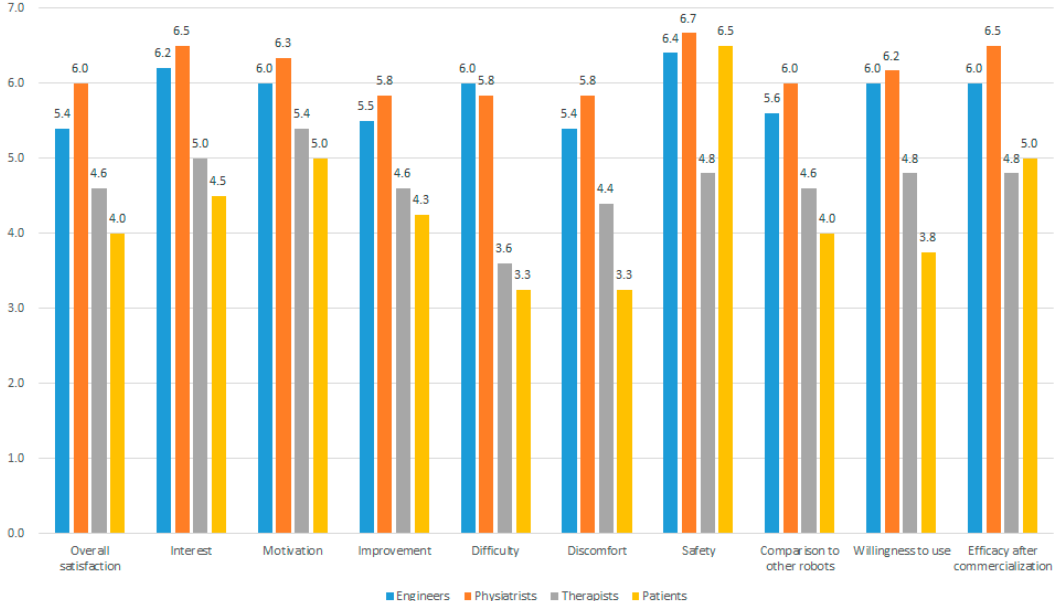
Figure 6. Usability test results for an image-processing based distal upper limb rehabilitation robot are shown for four categories of respondents. The scores are in a 7-point Likert scale, with 7 points representing most satisfactory or safe and 0 points for least satisfactory or unsafe. Patient data include responses of both chronic stroke patients and their long-term caregivers.